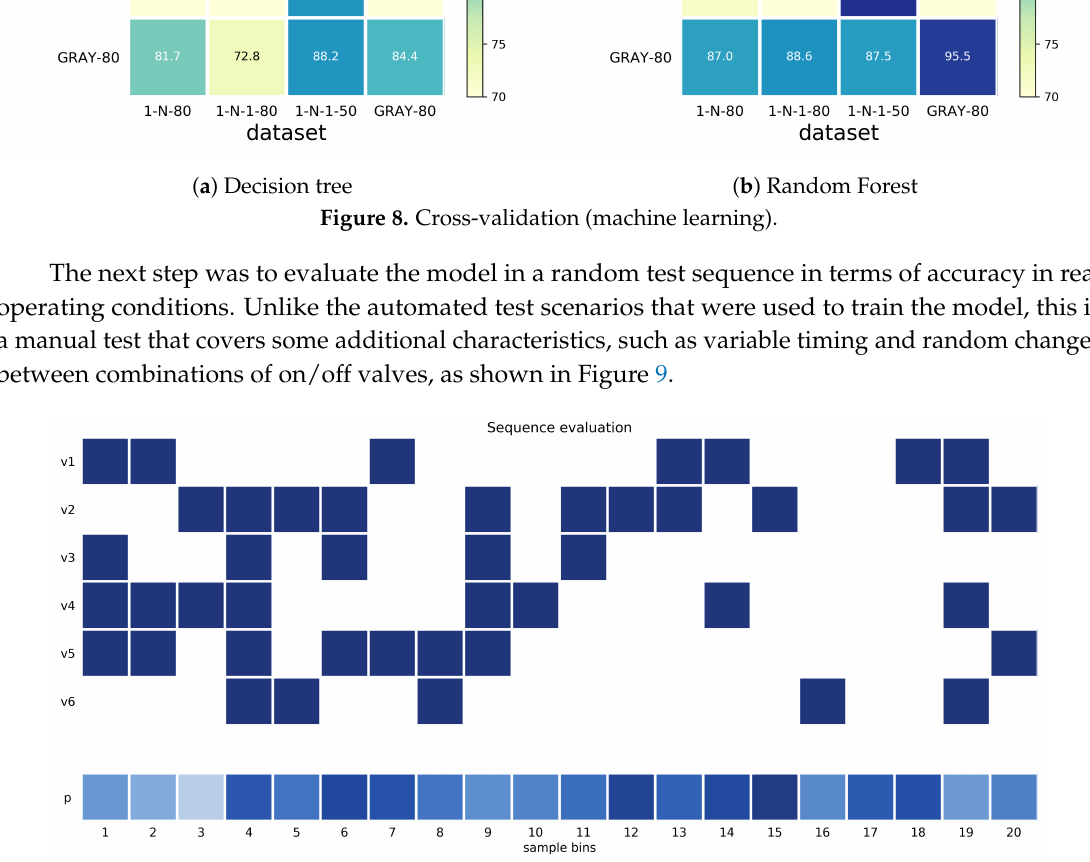
Figure 9. Random test sequence